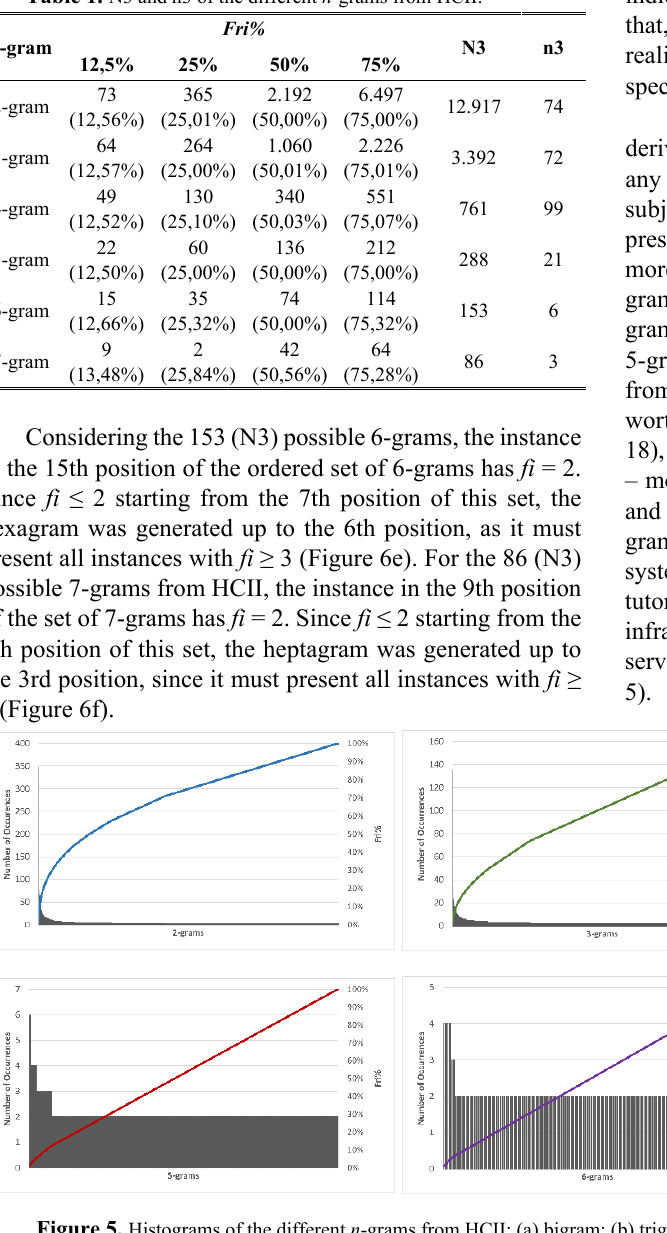
of ( n +1 ) -grams but do appear in the set of ( n +2)-grams